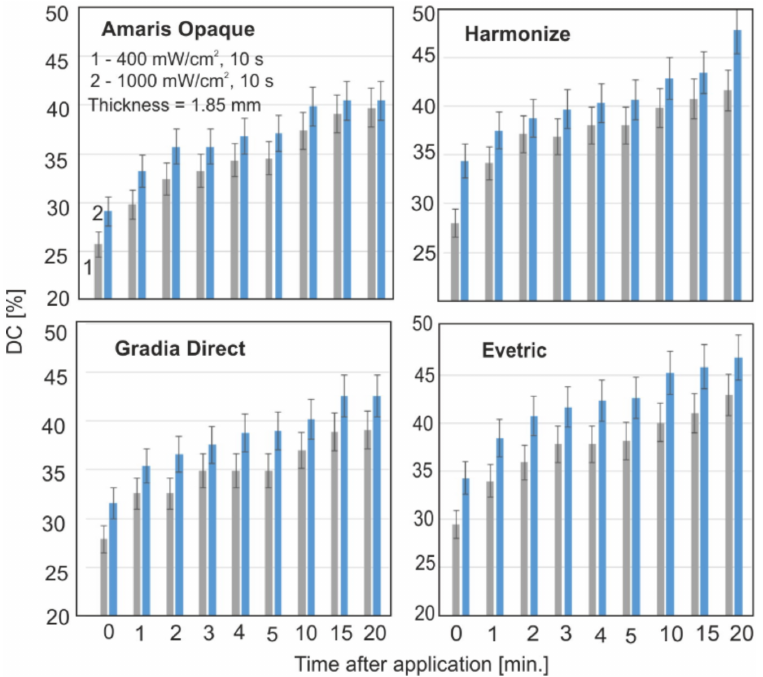
Figure 6. The polymerization kinetics of the materials with the average DC value.